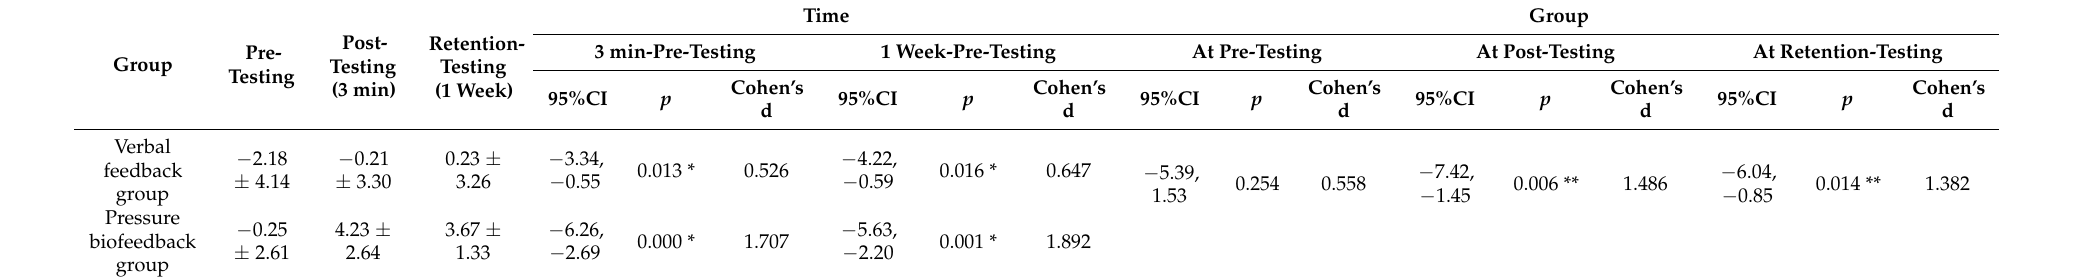
Table 1. Results of bladder base displacement (mm) in response to